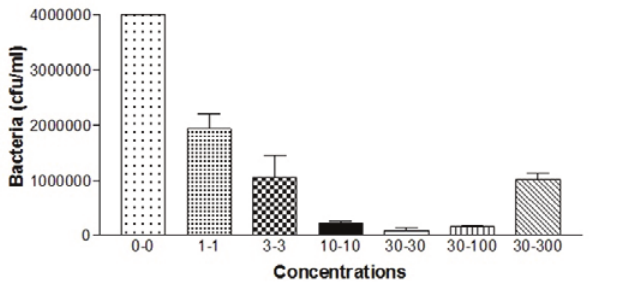
FIGURE 3 - Counts of bacteria at different concentrations of SnCl 2